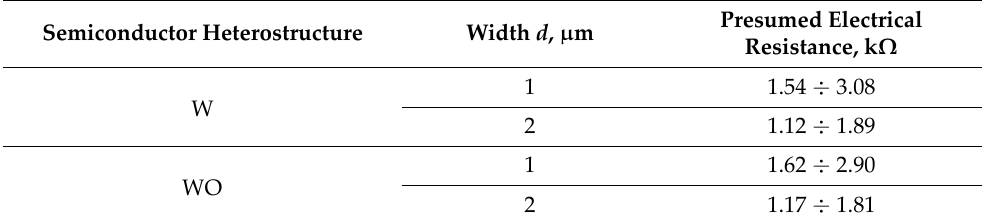
Table 3. Presumed range of electrical resistance of the illuminated bow‑tie diodes.